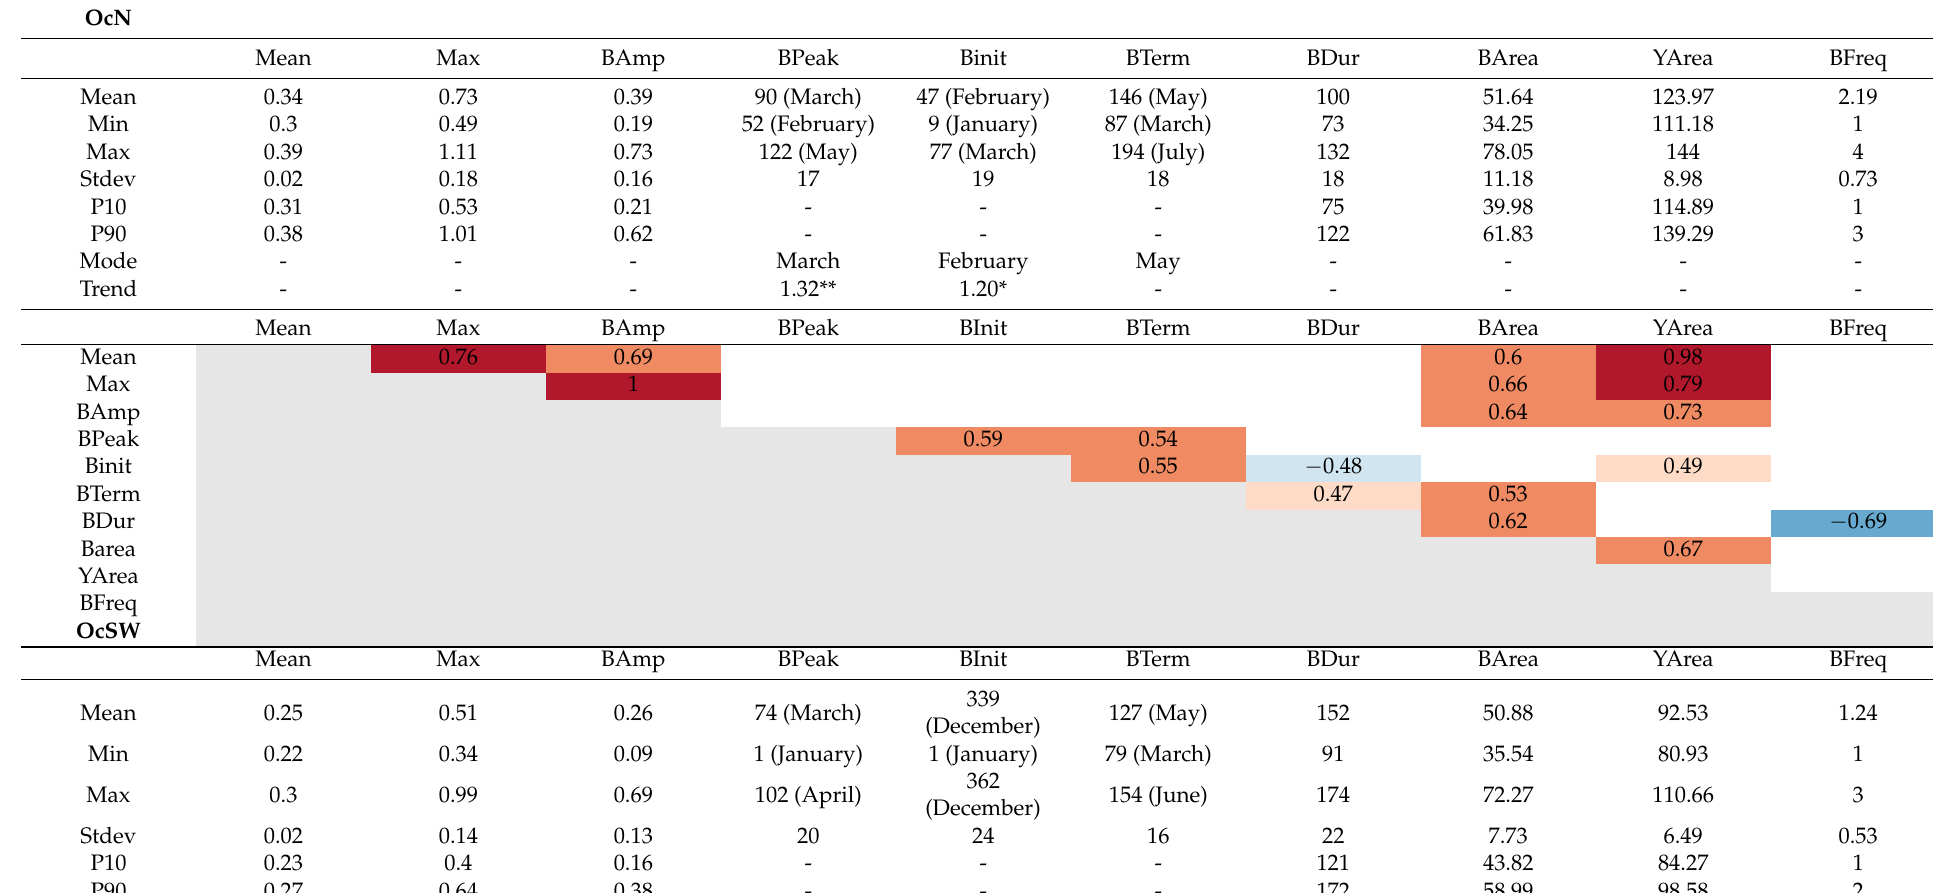
Table 3. Phenoregions statistical metrics and intercorrelation results calculated for phenology metrics (see Table 1 for full names and description). For each phenoregion, mean, minimum (Min), maximum (Max), standard deviation (Stdev), 10th and 90th percentiles (P10 and P90), and mode are presented for the phenology metrics for the 1998–2018 period. The linear trend (Trend) is the slope of the least-squares regression for each metric. Correlation results between phenology metrics are shown in red (positive correlation) or blue (negative correlation). Only statistically significant correlations and trends are displayed. *, ** and *** equals p -value < 0.1, p -value < 0.05 and p -value <